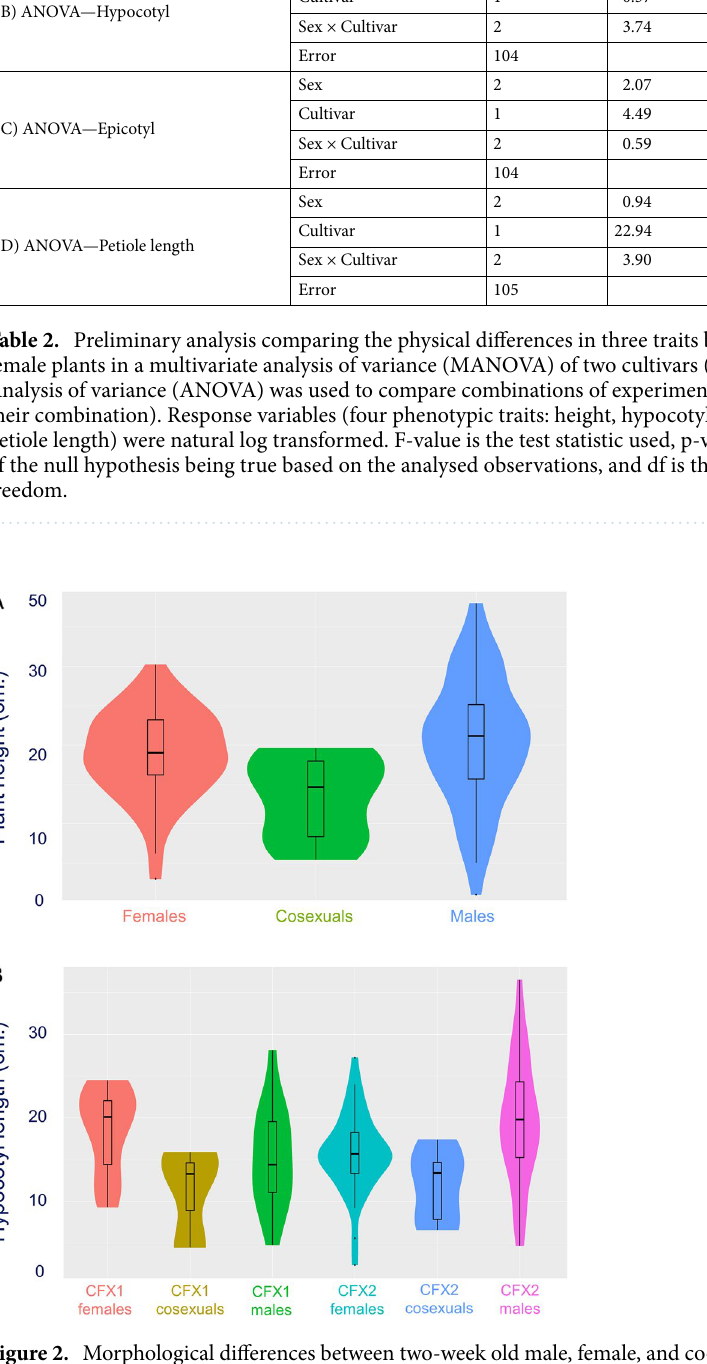
Figure 2. Morphological differences between two-week old male, female, and co-sexual (hermaphrodite) plants for ( a ) height and ( b ) hypocotyl length and ( c ) petiole length. This violin plot represents the distribution of the phenotypes; their medians are indicated by the white square, their medians are indicated by the thick black line, their interquartile ranges are represented by the black rectangle and the distribution is shown by the coloured area. Only traits that significantly affected sex or sex by cultivar interactions are shown